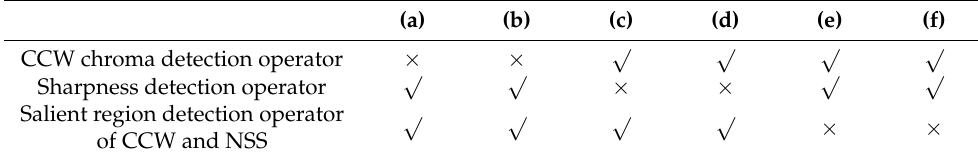
Table 1. The single feature detection results of the image in Figure